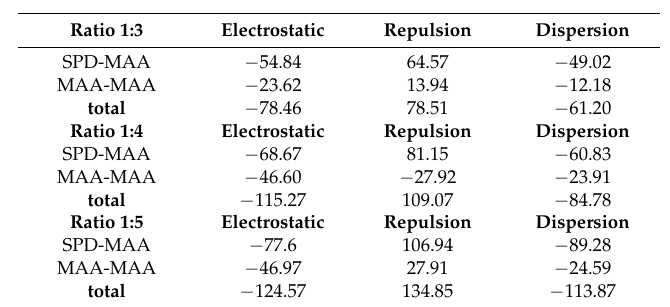
Table 6. This Energy decomposition of SPD-MAA complex at different ratios. (unit: kJ/mol).